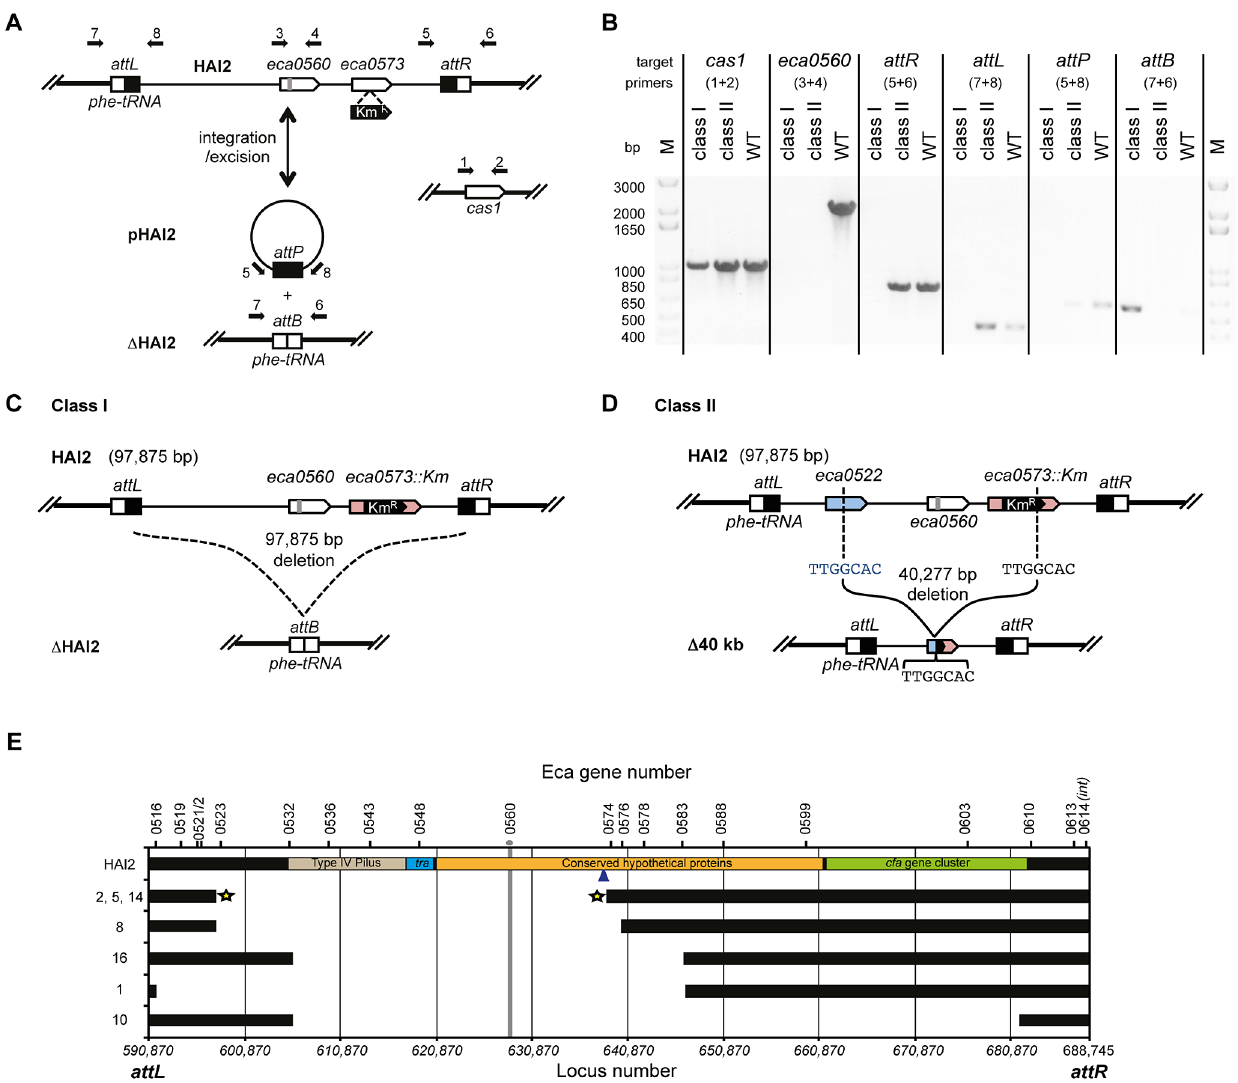
Figure 6. CRISPR/Cas–mediated chromosomal targeting causes rapid genome evolution. (A) Schematic of HAI2 inserted in the P. atrosepticum genome. The attL and attR sites are indicated by black and white boxes respectively, eca0560 and eca0573 are shown as white arrows and the protospacer in eca0560 is indicated in grey and the Km R marker in eca0573 is depicted in black. Excision of HAI2 results in the circularised form, pHAI2, which contains the attP site and results in the generation of the attB site located within the phe-tRNA gene in the genome. In the absence of the circularised pHAI2 form, the strain is designated D HAI2. Primers used for strain confirmation in (B) are shown as black arrows and the cas1 gene was used as a positive control. (B) PCR results for representative class I and class II mutants and the WT. PCR was performed for cas1 , eca0560 , attR , attL , attP and attB and with primers shown in part (A). Schematic representations of (C) the class I mutants (designated D HAI2) that have precisely lost the 97,875 bp island and (D) the class II mutants 2, 5 and 14 containing a 40,227 bp deletion between TTGGCAC sequences in both eca0522 and internal to the Km R insertion in eca0573 . (E) Scale genetic map of the 7 classified HAI2 class II mutants defining the deleted regions. Black bars indicate the presence of the gene as specified. The gray vertical line represents the CRISPR-targeted eca0560 gene. The star represents three accurately sequenced junctions. The blue arrow depicts the site of Km insertion within the chromosome. Class II mutants are numbered as in Figure S4 and their PCR profiles are shown in Figure S5.